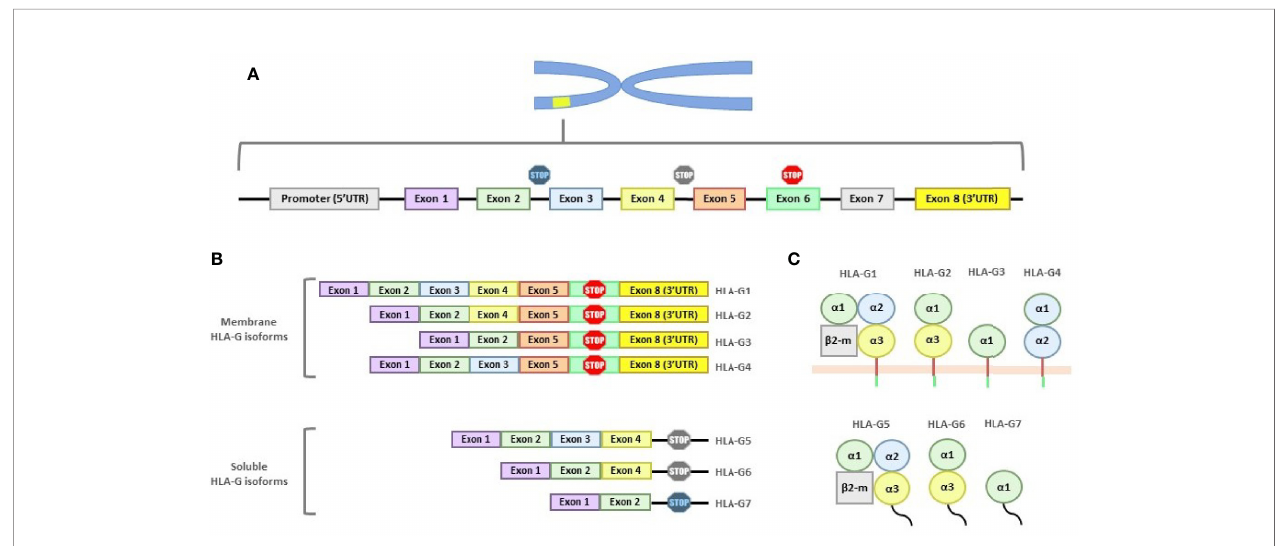
FIGURE 1 | Structure of the HLA-G gene and its products. (A) HLA-G gene is composed of 7 introns and 8 exons. Exon 1 encodes the signal peptide; exons 2, 3 and 4 encode the a 1, a 2 and a 3 subunits; exon 5 encodes the transmembrane region; and exon 6 the cytoplasmic region. Exons 7 and 8 are always transcribed, although exon 7 is never present in the mature mRNA and exon 8 (3 ’ UTR region) is not translated due to the stop codon present in exon 6. (B) Mature mRNA of the different HLA-G isoforms. All isoforms show exon 1 and 2. Soluble isoforms are generated by alternative splicing which eliminates the exons involved in membrane binding. (C) The seven HLA-G isoforms, grouped whether they are membrane-bound or soluble, are